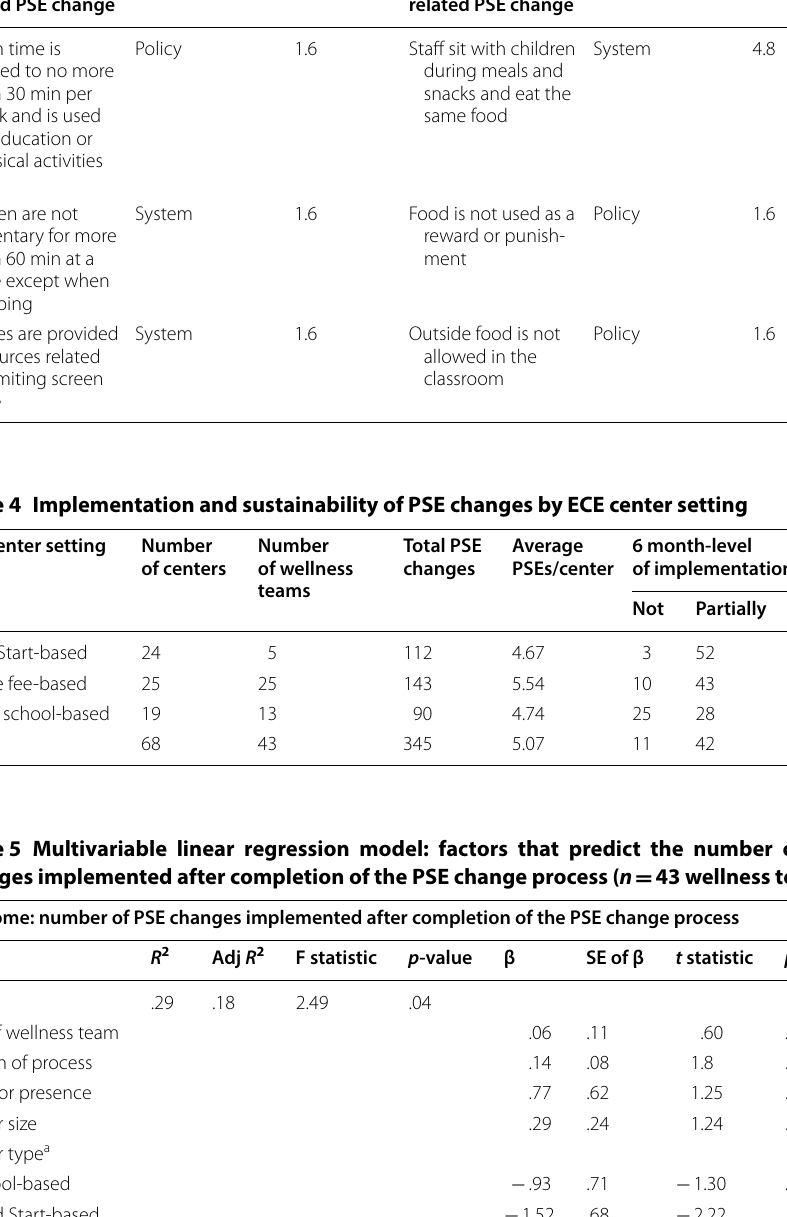
a Reference category for center type is private fee-based ECE centers; * p <